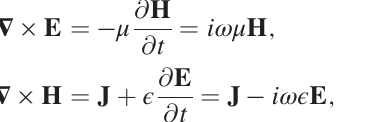
Ω ¼ ð k δ Þ − 1 and for Δ ¼ L= δ ¼ 20